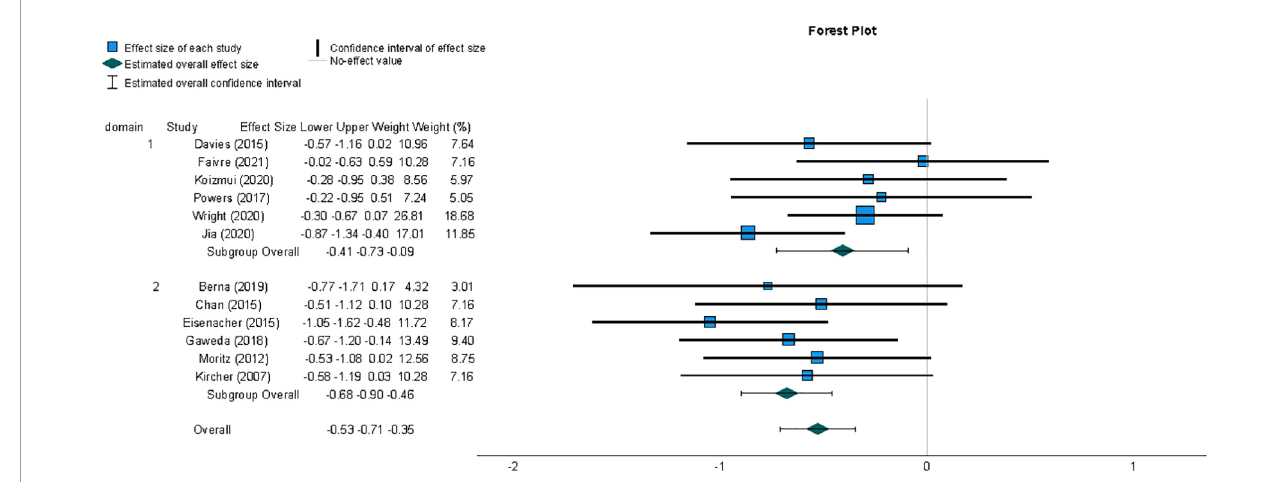
FIGURE3 Forest plot of the distribution of Hedges’ g effect sizes for metacognitive sensitivity across studies of samples with psychosis-related symptoms, based on a random- effects analysis, displaying effects by arranged sub-group of task domain, which was either perceptual (1) or non-perceptual (2). Lower metacognitive sensitivity in those with psychosis-related symptoms is indicated by a negative effect size. The summary effect size is indicated by a diamond marker, underneath the individual study effect